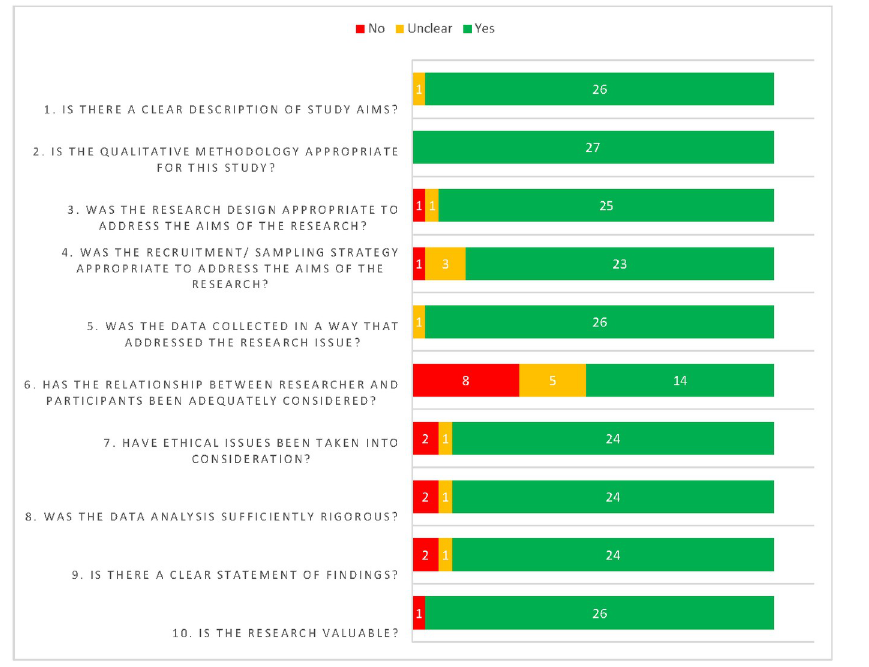
Fig 2. Summary of critical appraisal